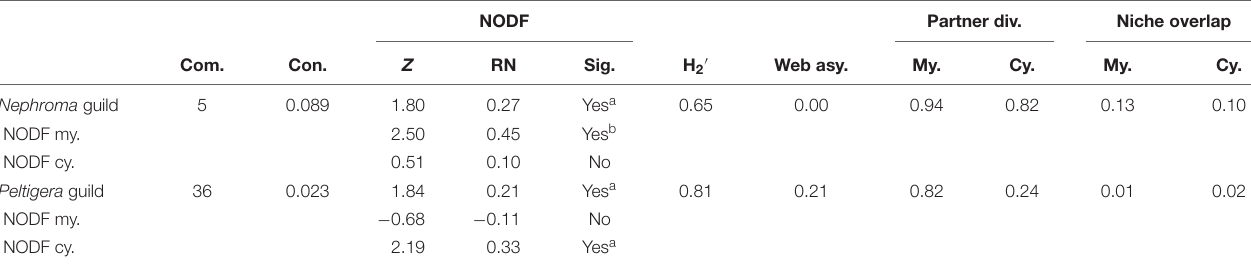
TABLE 2 | Network level information from the different lichen guilds, including the number of compartments (Com.) within the network not connected via mycobiont–photobiont interactions; connectance (Con.) indicating the proportion of realized interactions; NODF nestedness metric with Z score ( Z > 1.64 indicates significance at p = 0.05), relative nestedness (RN) values, and whether the result differs significantly from a random matrix (Sig.), also separately to mycobionts (NODF my.) and cyanobionts (NODF cy.); specialization within the network (H 2 ’), web asymmetry (Web asy.) indicating the difference between the numbers of mycobiont taxa and cyanobacterial variants; partner diversity (Partner div.) indicating the diversity and evenness of distribution among the interactions; and niche overlap indicating the similarity of interactions between taxa, i.e., the sharing of the mycobionts (My.) or cyanobionts (Cy.). NODF Partner div. Niche overlap